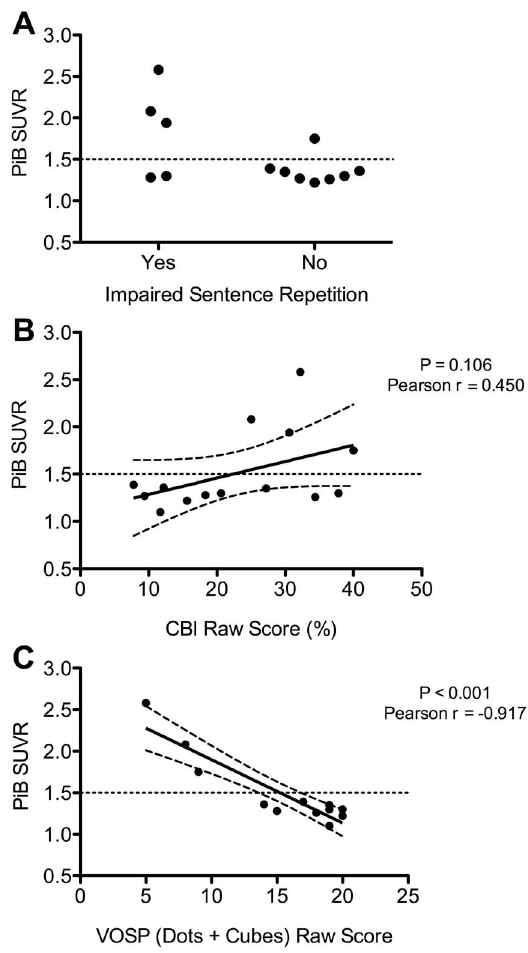
Figure 1. Correlates of PiB-binding in CBS patients. A – Impaired sentence repetition was detected in 75% of PiB-positive patients (defined as an SUVR ratio of . 1.5) compared to only 22.2% of PiB- negative patients (P=0.07). B – There was a trend (P=1.06) for a correlation between increased PiB-binding (reflected in increased SUVR ratio) and functional impairment (reflected by an increased CBI total). C – Increased PiB-binding (reflected by an increased SUVR) was strongly and highly significantly (P , 0.001) correlated with visuospatial dysfunction. Note – PiB=Pittsburgh Compound B, SUVR=standardized uptake value ratio, CBI=Cambridge Behavioural Inventory, VOSP=Vi- sual Object and Space Perception Battery. In Figure 1B and 1C the line of best fit is shown, with 95% confidence